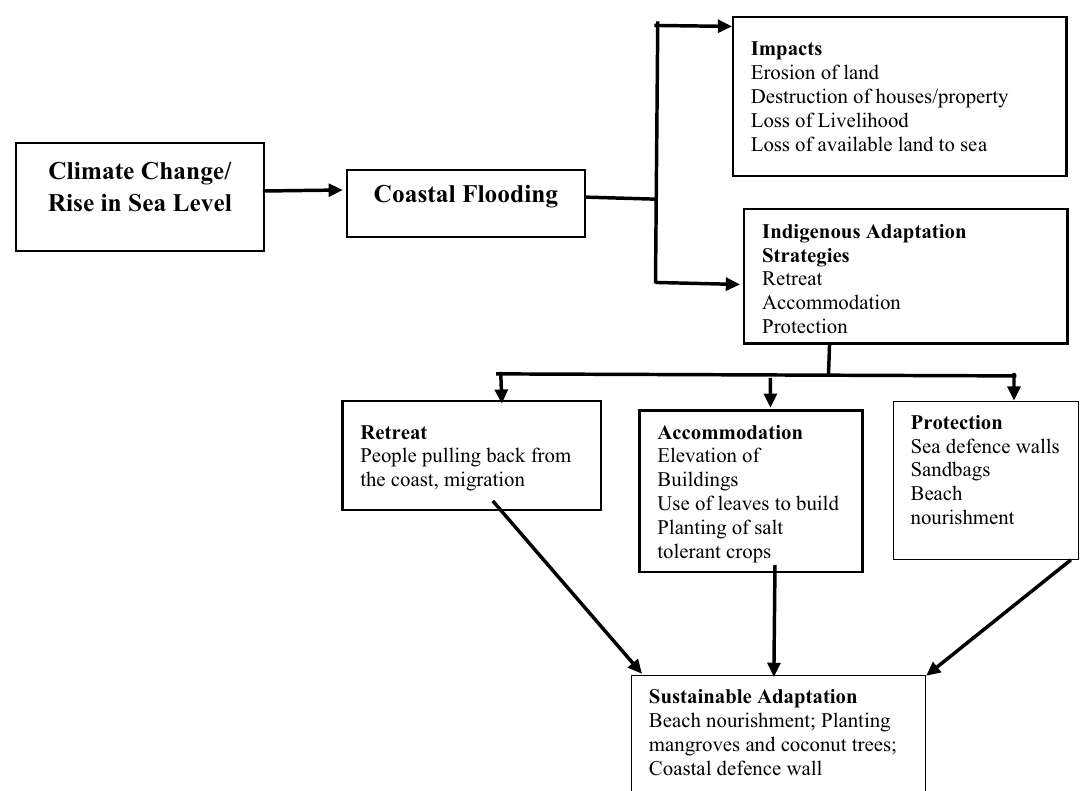
Fig.1 Sustainable Coastal Management for Adaptation Source: Adapted from Jarungrattanapong and